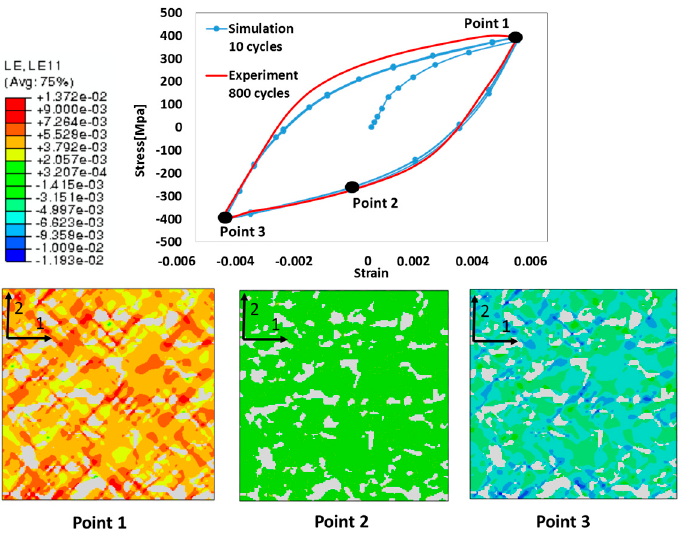
Figure 9. Evaluation of the inhomogeneous strain distribution within the ferrite phase along the loading direction at different stress points.